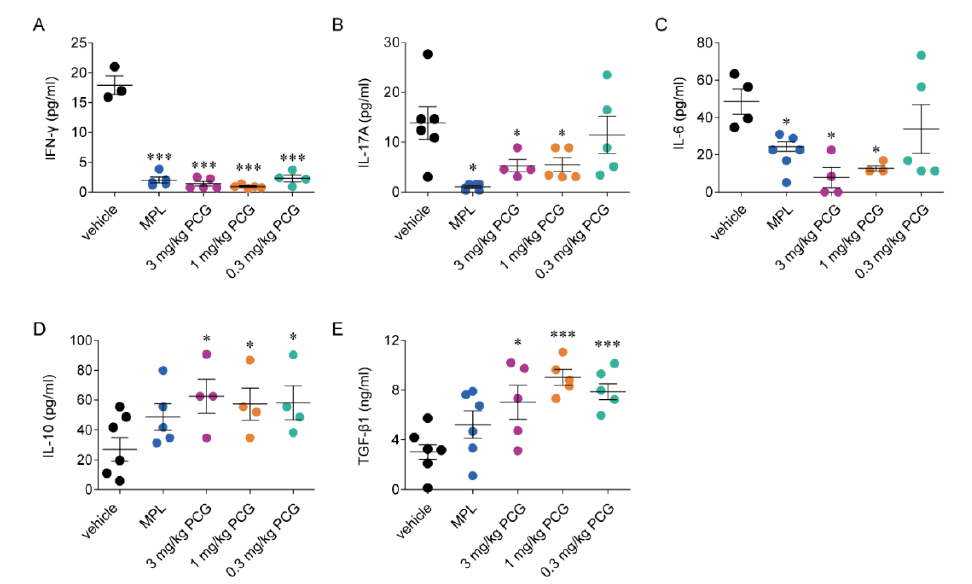
Figure 4. PCG decreases pro-inflammatory cytokines and increases anti-inflammatory cytokine levels in NZB / W F1 mice. ( A – E ) Plasma concentrations of IFN- γ ( A ), IL-17A ( B ), IL-6 ( C ), IL-10 ( D ), and TGF- β 1 ( E ) were measured in NZB / W F1 mice at 30 weeks of age (mean ± SEM, n = 3–7 / group). Mice were treated with MPL and PCG 3 times a week. * p < 0.05 and *** p < 0.001 versus vehicle. Two-tailed Student’s t -test ( A – E ).